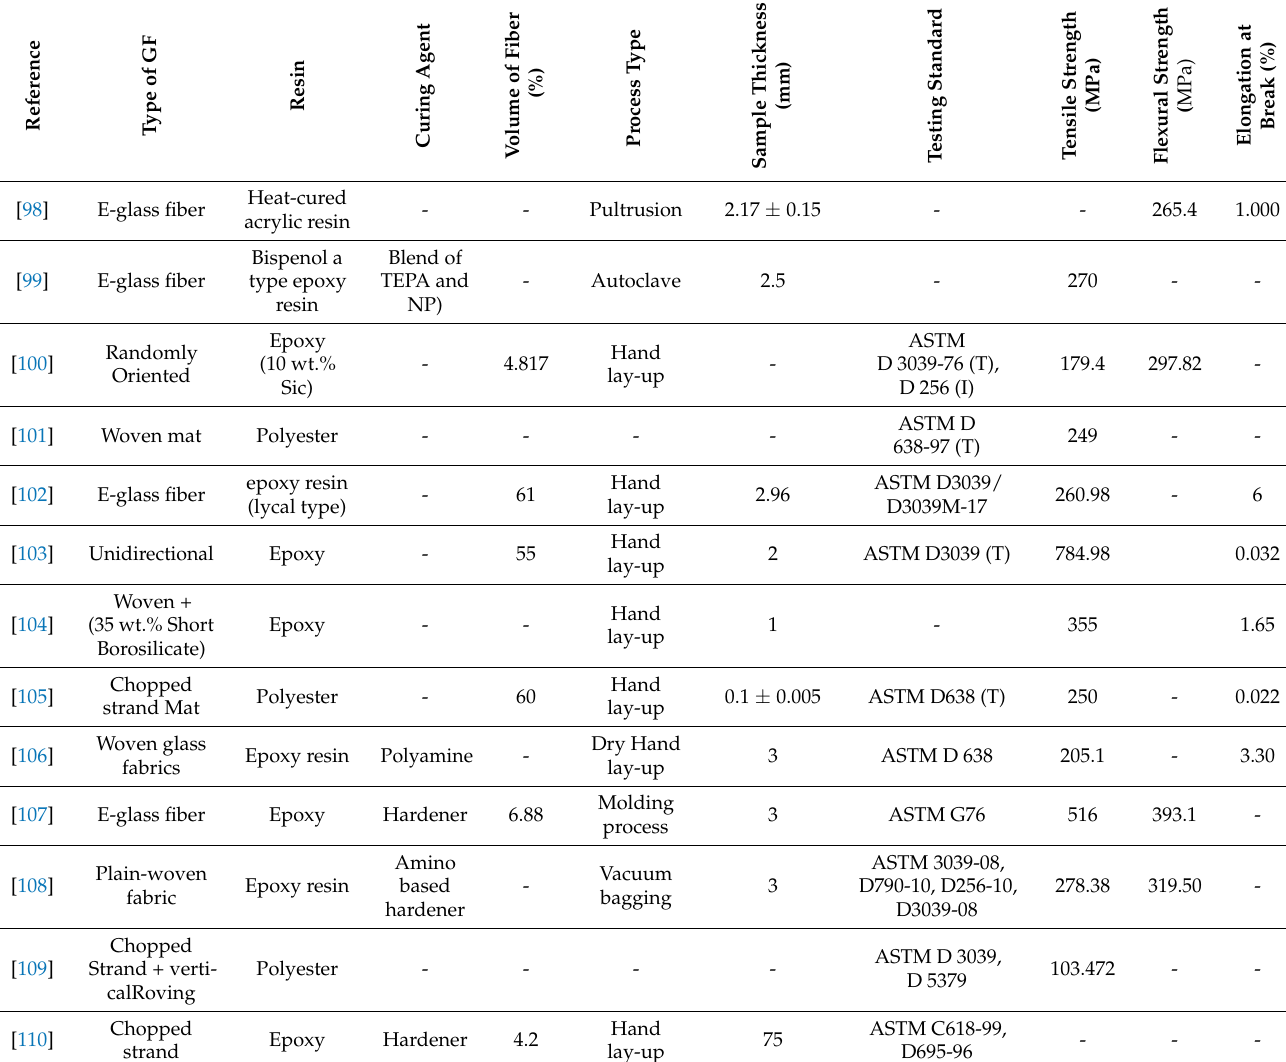
Table 4. Main mechanical properties of GFRP composites according to different types of reinforcements and matrix.